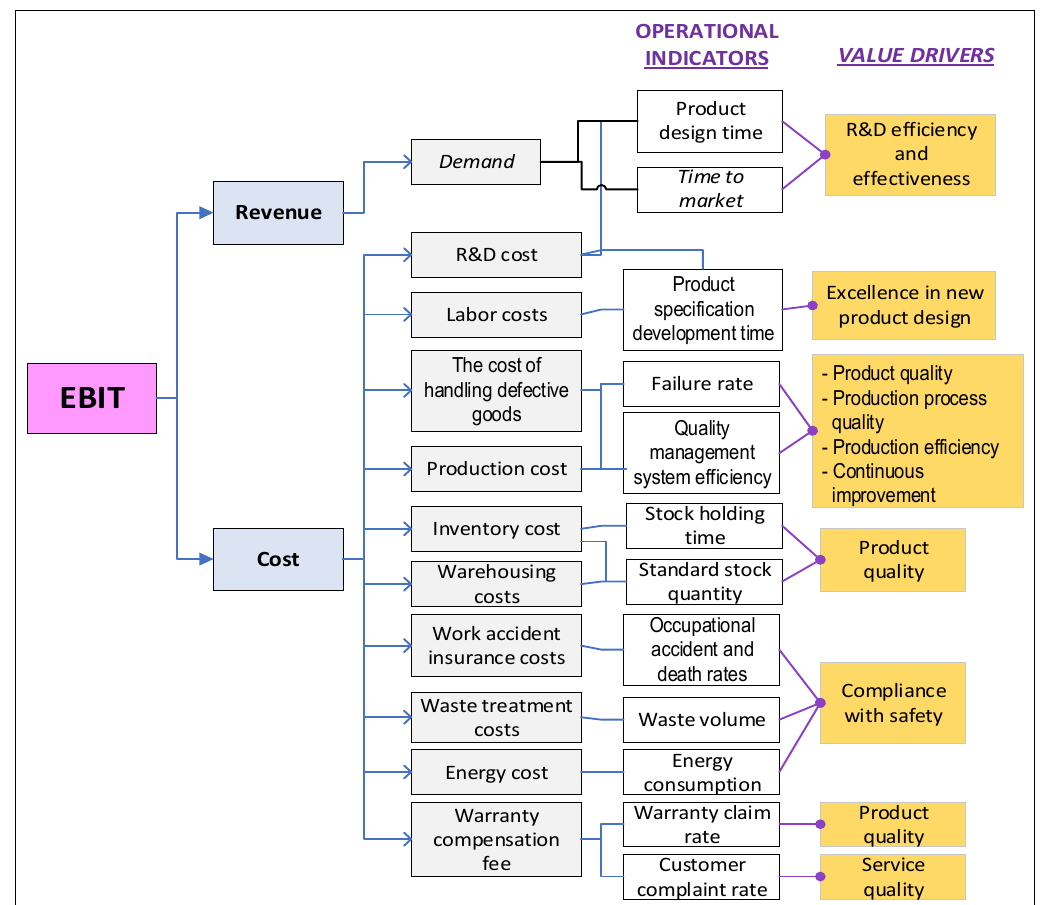
Figure 9. Relationship of EBIT, operational indicators, and value drivers.